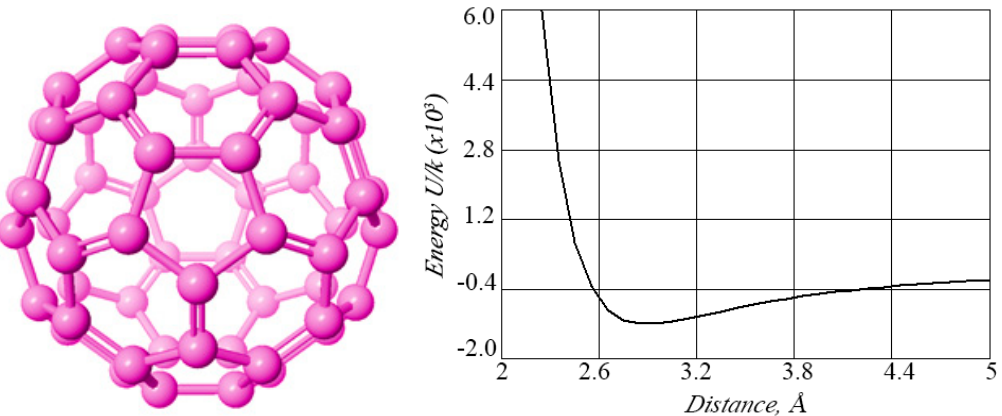
Figure 1. Schematic representation of C 60 fullerene and average potential energy of its impact wrt the fullerene next to it. The distance is defined as the distance between the fullerene shells.